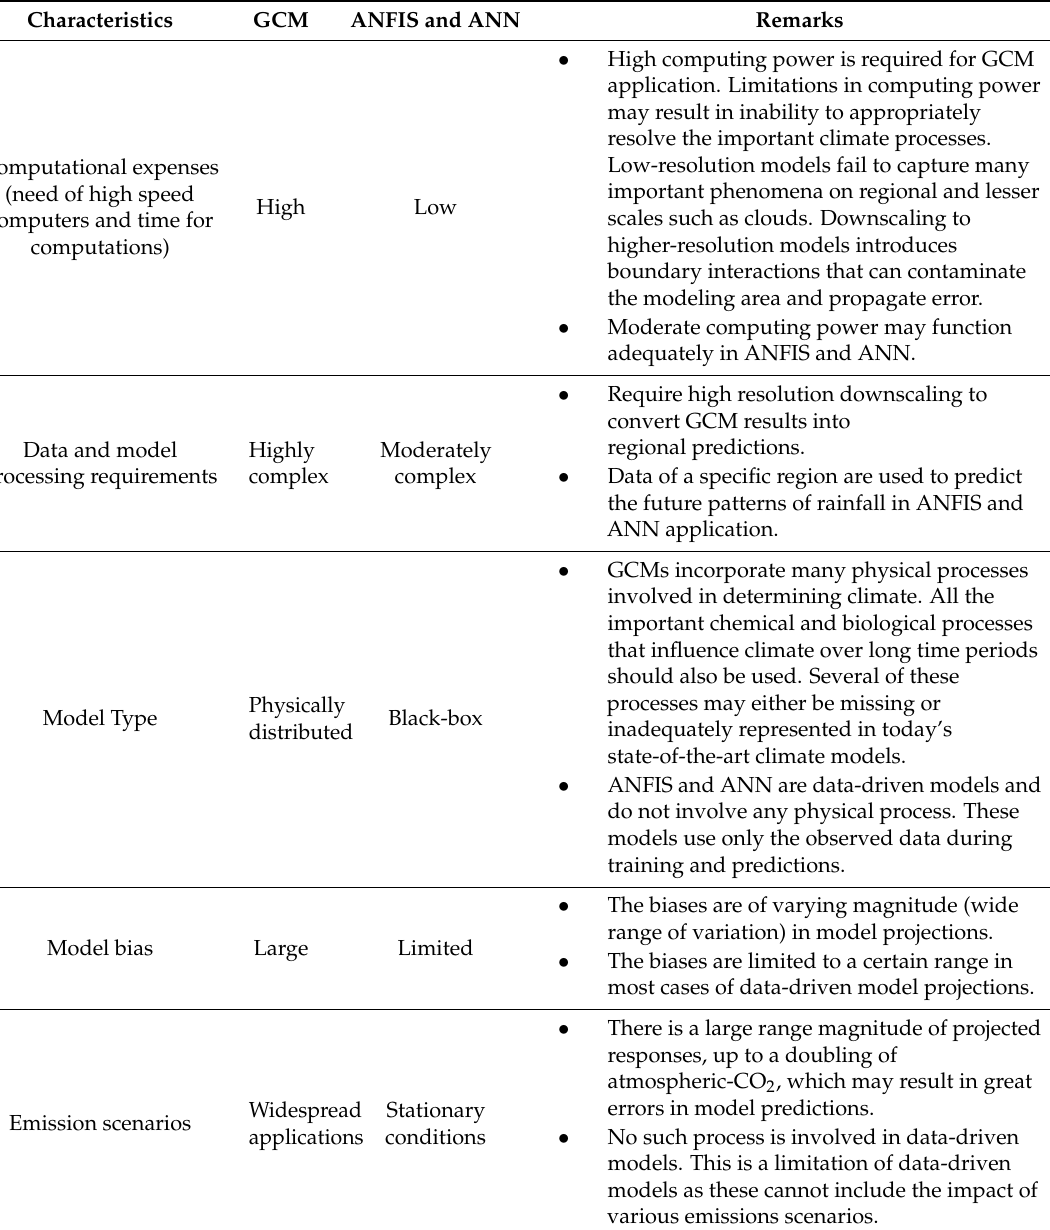
Table 1. Comparison of GCM with data-driven